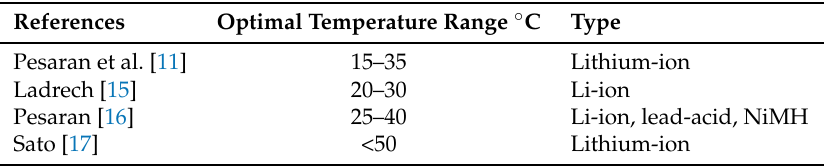
Table 1. Advised operating temperature range for